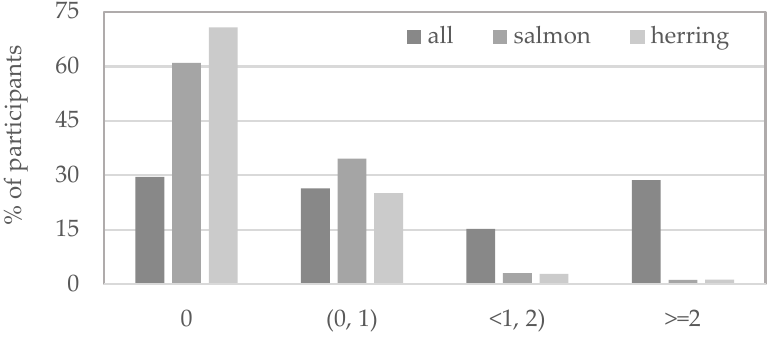
Figure 3. Percentage of female post-primary school students not consuming and consuming (0, 1), <1, 2) and ≥ 2 servings of fish and fish products including salmon and